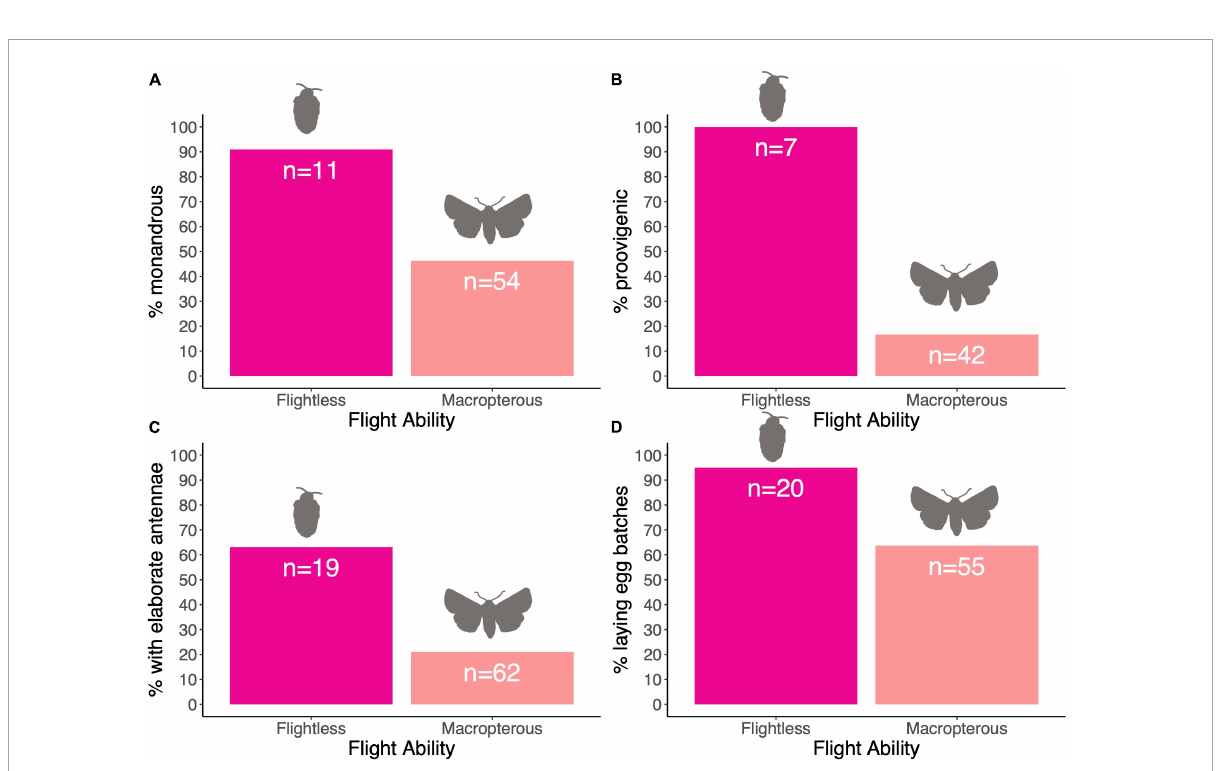
FIGURE3 (A–D) Percentage of species with particular traits relative to the flight ability of